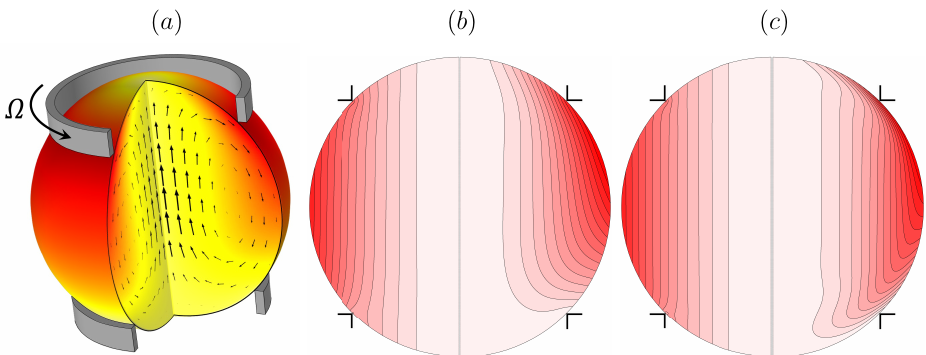
Figure 2. ( a ) Schematic of the ring-sheared drop, and vortex lines in a meridional plane at ( b ) Re = Ω R 2 / ν = 10 2 and ( c ) Re = 10 3 (in each, the left hemisphere is the flow at Bq = 10 − 4 and the right at Bq = 10 2 ). (Reproduced with permission from [52], published by American Physical Society